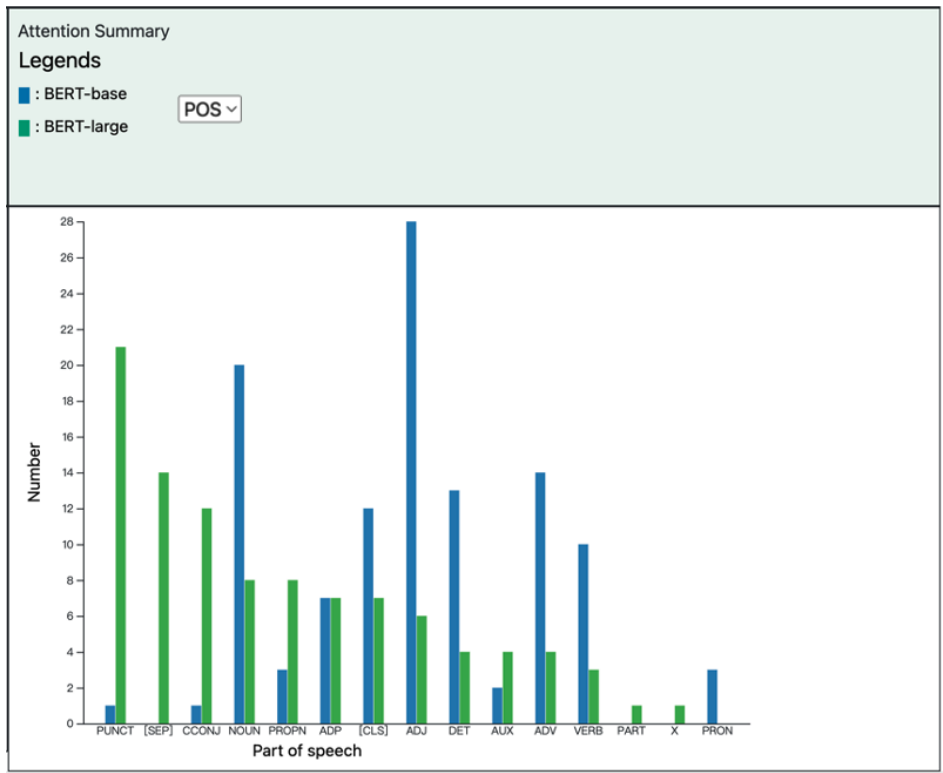
Figure 13. Attention summary view. This view statistically summarizes the fundamental linguistic attributes of all attention words in the attention